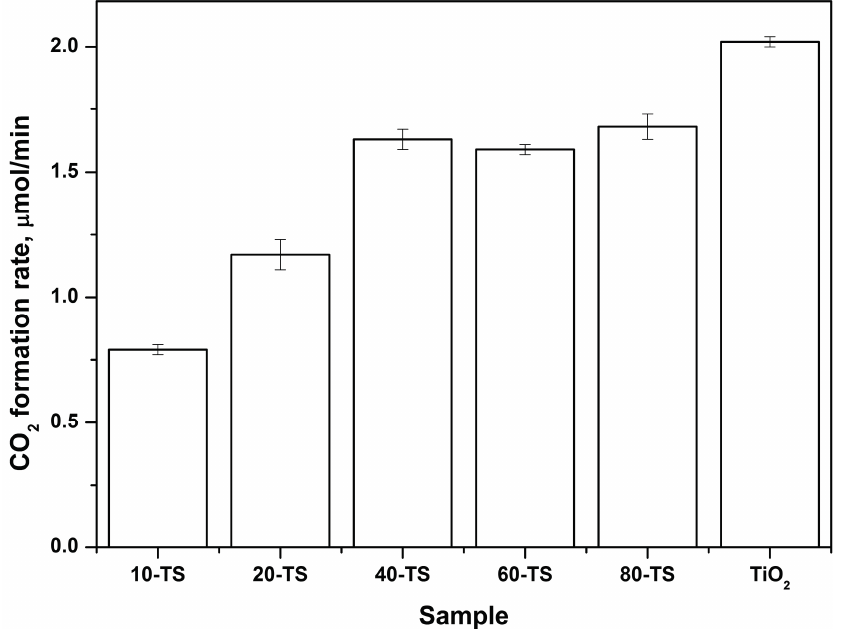
Figure 5. Dependence of the CO 2 formation rate during acetone PCO on the TiO 2 content for TiO 2 /SiO 2